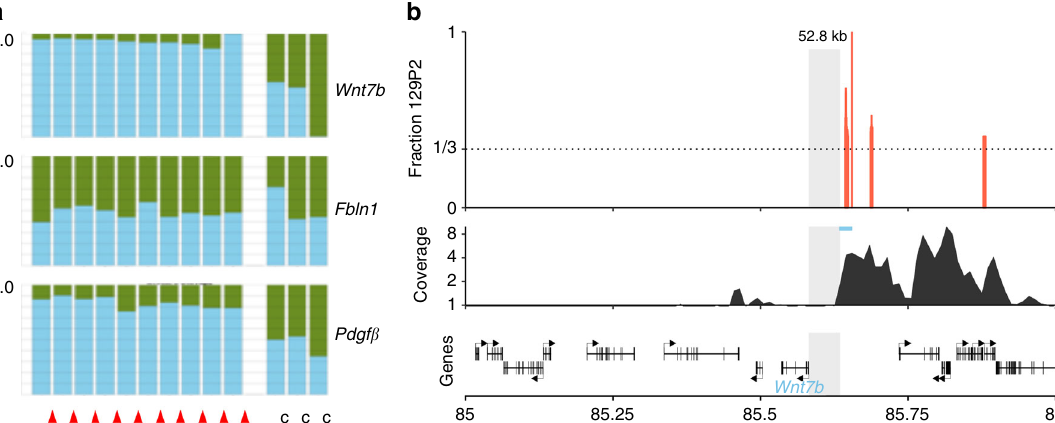
Fig. 5 The implication of 129P2 Wnt7b allele in the development of skin tumours. a Fraction ( Y -axis) of FVB/N allele derived transcripts (green) and 129P2 allele derived transcripts (blue) of Wnt7b , Fbln1 and Pdgf β in 10 independent skin tumours and 3 control (soft tissue sarcomas) tumours ( X -axis). b Window of region of interest (chr15:85644260-85645382) with signi fi cant enrichment of the 129P2 allele reads in the H3K27-Ac ChIP-seq data region of interest. Non-informative (no SNP differences between FVB/N and 129P2) reads and reads without signi fi cant difference between FVB/N and 129P2 are not indicated. The super-enhancer region is 52.8 kb upstream of the transcription start site of Wnt7b